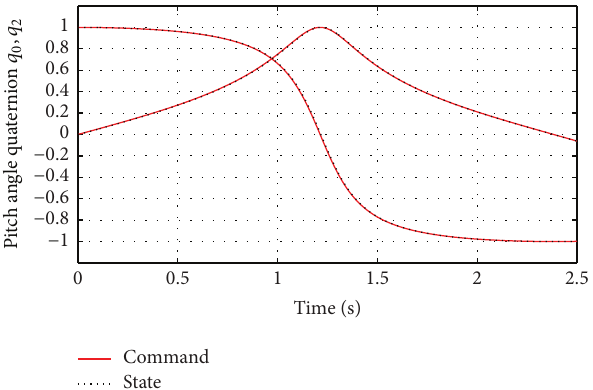
Figure 16: Command and state pitch angle for a constant thrust loop.